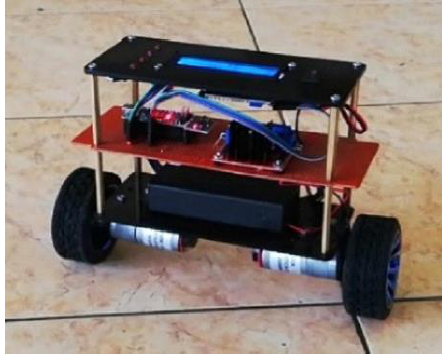
Figure 10. Self-balancing robot